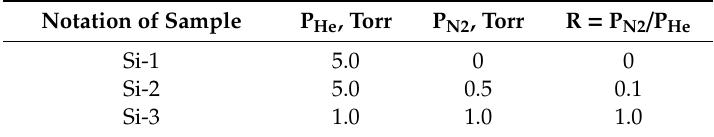
Figure 1. Scheme of pulsed laser ablation to deposit Si-based nanostructured films. A beam from UV excimer laser is directed at the angle of 45 deg. onto a rotated Si target. The ablated material is deposited on a substrate located 2–3 cm above the target surface. The target–substrate distance is selected in such a way that visible plasma plume area contacts the substrate surface. Table 1. Representative samples of nanocrystalline silicon prepared at di ff erent partial pressures of helium (P He ) and nitrogen (P N2